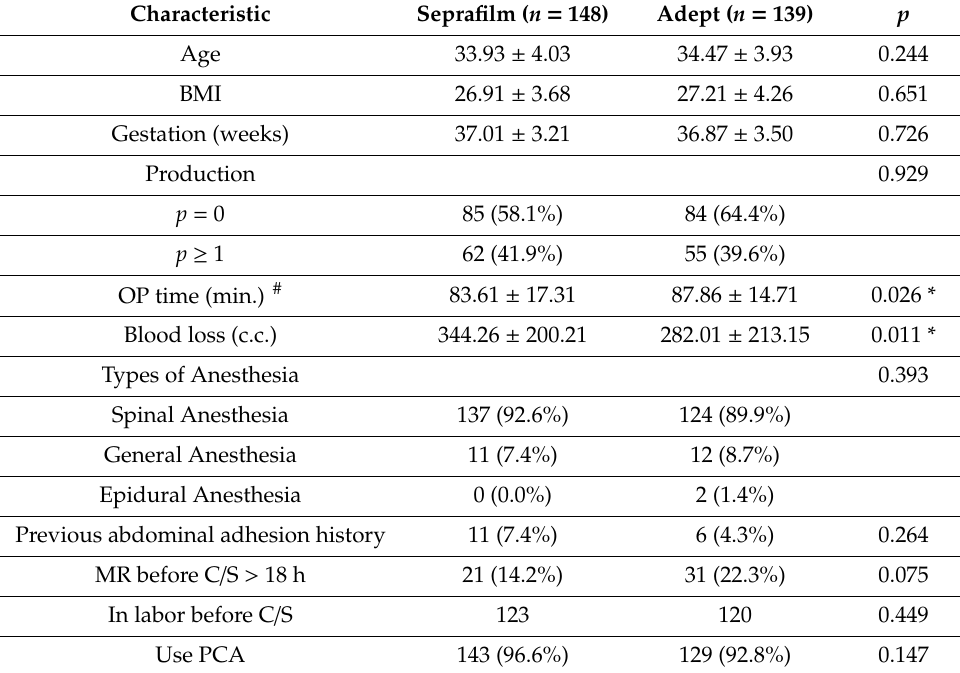
Table 1. Baseline characteristics of the